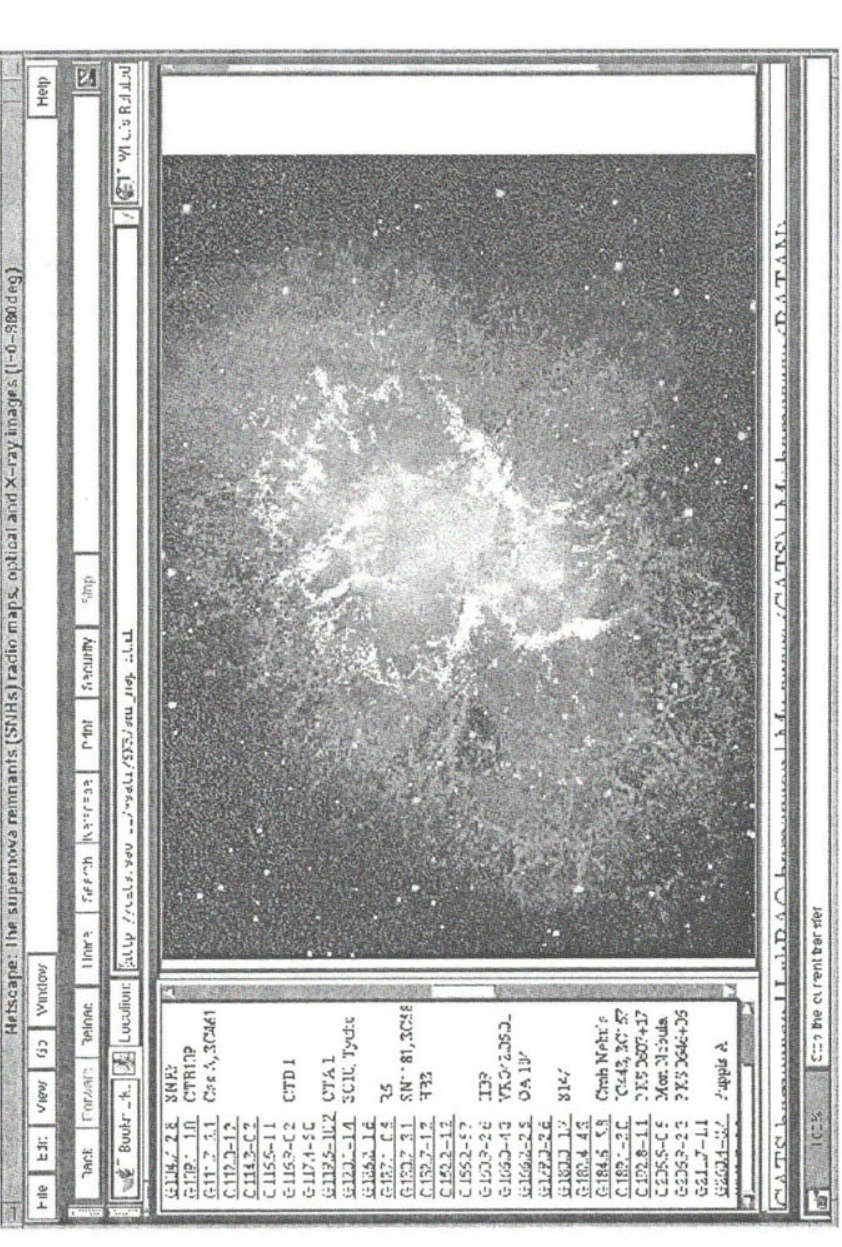
Fig. 2. The web-page with the "on-line" plot of the radio spectrum of the Crab